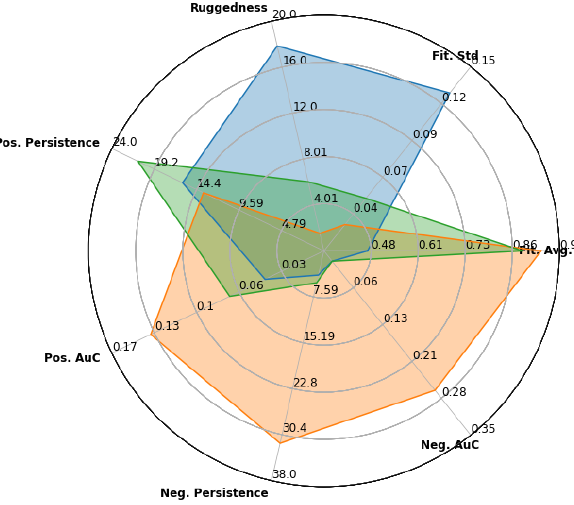
Figure 1. Fitness landscape footprint of So2Sat LCZ42 for Sentinel-1 (blue), Sentinel-2 (yellow), and both sensors together (green), on CNN image classifiers NAS